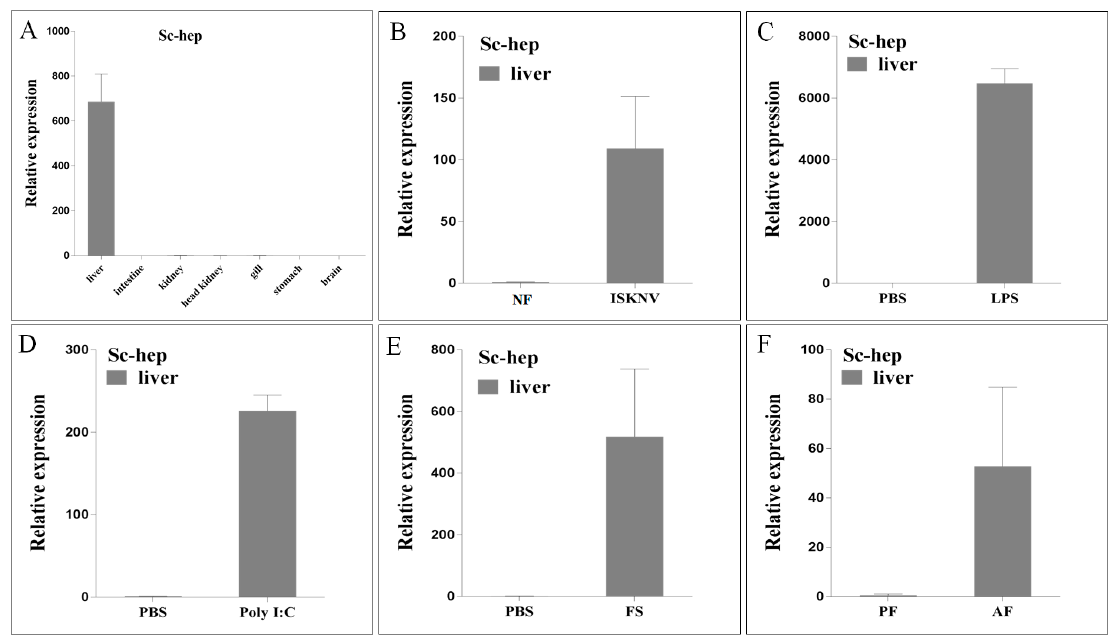
Figure 4. Expression of Sc-hep . ( A ): Expression of Sc-hep mRNA in seven tissues. ( B – E ) and ( F ) show the differential expression of the Sc-hep gene in the liver caused by spleen and kidney necrosis virus (ISKNV) infection, lipopolysaccharide (LPS) injection, polyinosinic–polycytidylic acid (Poly I:C) injection, ferrous sulfate (FS) overload, and artificial feed domestication, respectively. AF: fish fed with artificially diet; PBS: phosphate-buffered saline; PF: fish cultured with live prey; NF: normal fish.